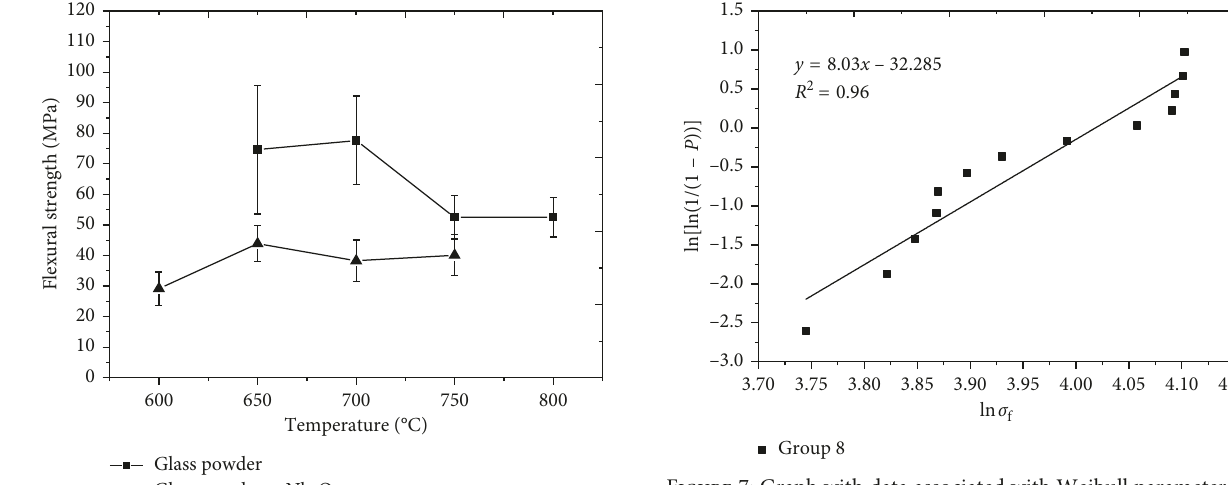
Figure 7: Graph with data associated with Weibull parameters for Group 4.